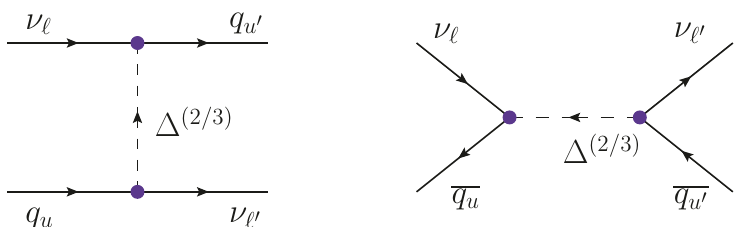
Figure 7 . Feynman diagrams contributing to (cid:23) ‘ + q u exchange. Here (cid:23) ‘ ; (cid:23) ‘ 0 are generic neutrino (cid:13)avors and q u ; q u 0 are generic up-type quarks.